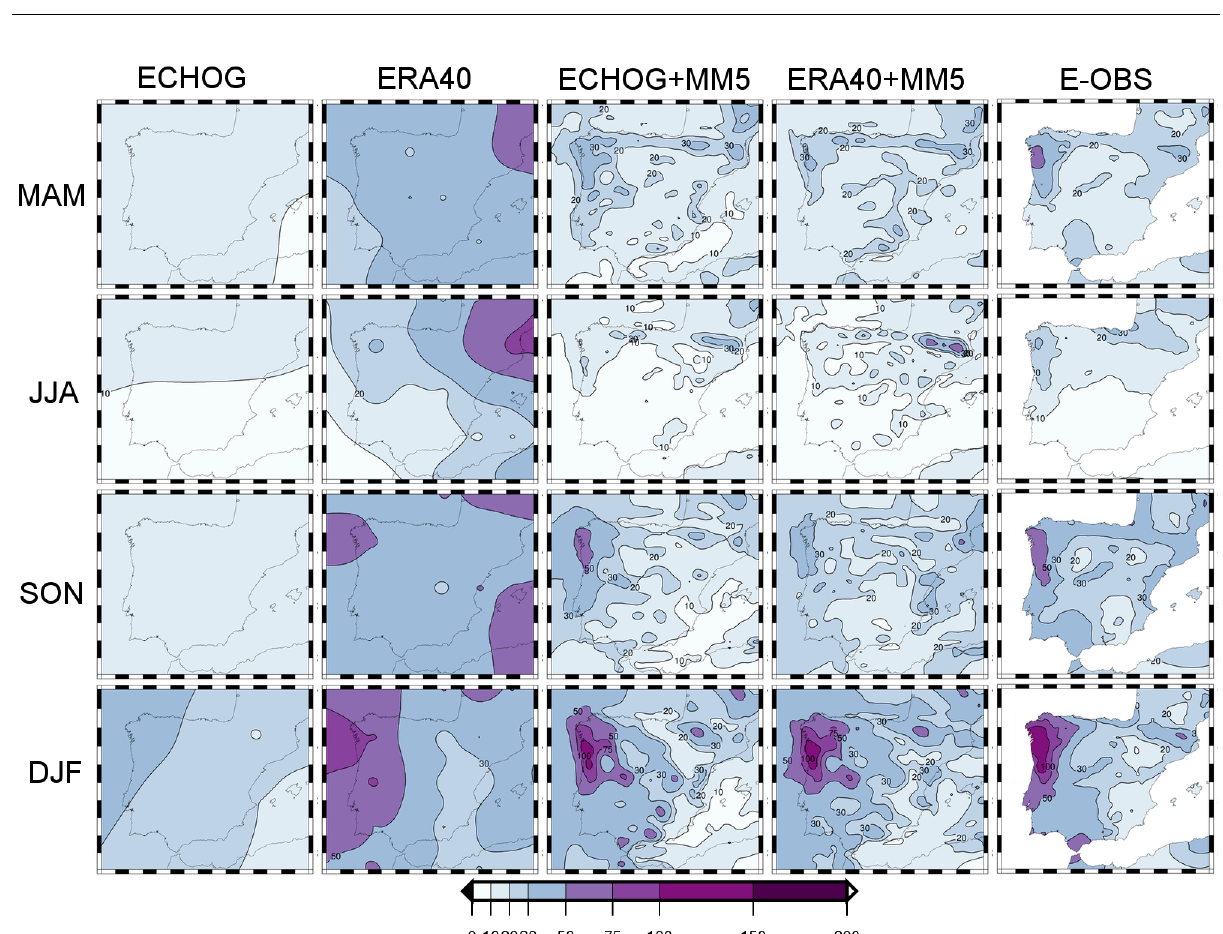
Fig. 7. Standard deviation (in mm/month) of seasonal mean series of precipitation in the period 1961-1990 for ECHO-G, ERA40, and MM5 nested to both (by columns) in all the seasons (by rows). Last column depicts the values for the E-OBS data base. All fields have been interpolated onto a 7-minute regular grid to ease the visual comparison.